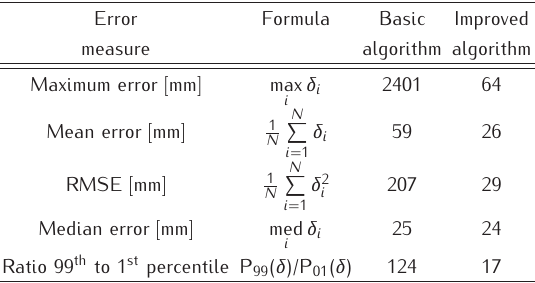
Table 2. Comparison of statistical parameters for errors of basic and improve- ment algorithm for chosen test